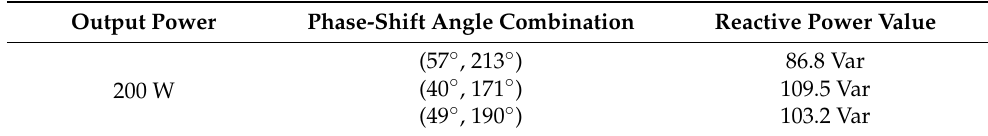
Table 6. Reactive power when the transmitted power is 200